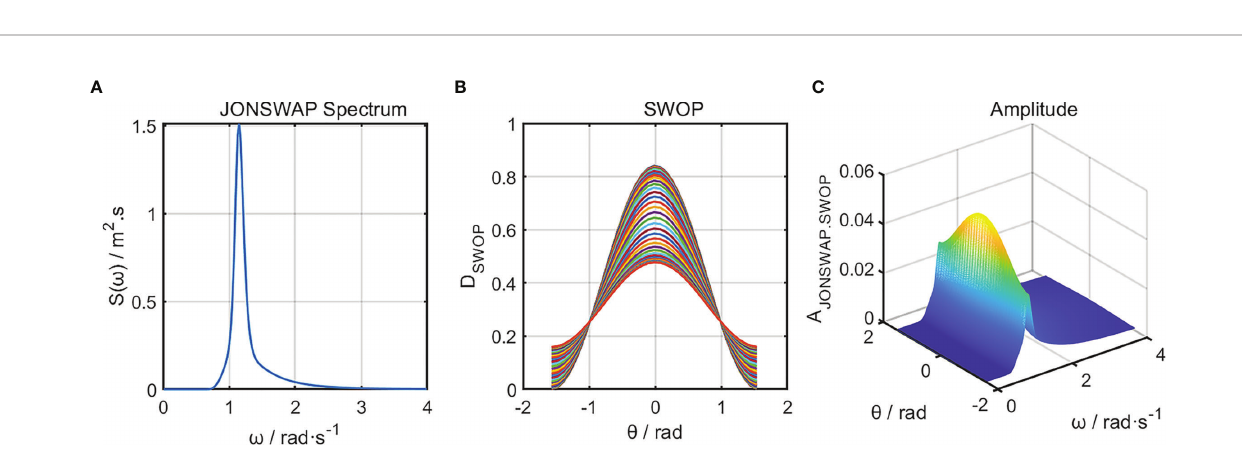
FIGURE 3 | U 10 = 17 m / s (A) JONSWAP spectrum; (B) SWOP directional extension function; (C) A JONSWAP – SWOP